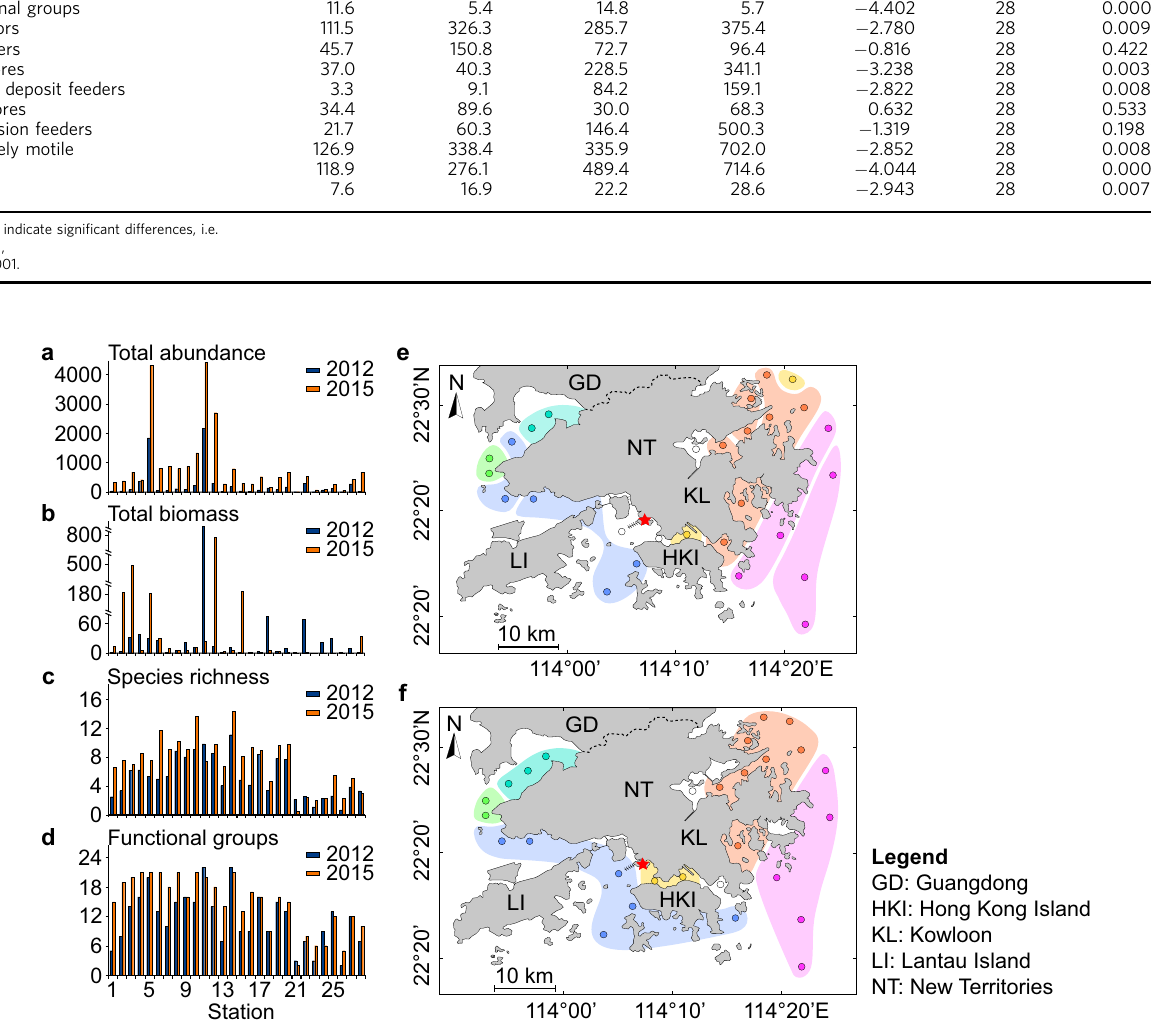
Fig. 3 The biotic responses and spatial distribution of macrobenthos among-site groups before (2012) and after (2015) the trawl ban. a Total abundance (number of individuals). b Total biomass (g). c Species richness. d Functional groups. The biotic variables at each site were calculated based on the pooled data from fi ve grab samples covering a total area of 0.5 m 2 . e Site groups in the 2012 survey before the trawl ban. f Site groups in the 2015 survey after the trawl ban. The distribution pattern of site groups was made based on the results of CLUSTER analysis (Supplementary Fig. 3) showing nine signi fi cantly distinct site groups before and six after the trawl ban (SIMPROF procedure, P <